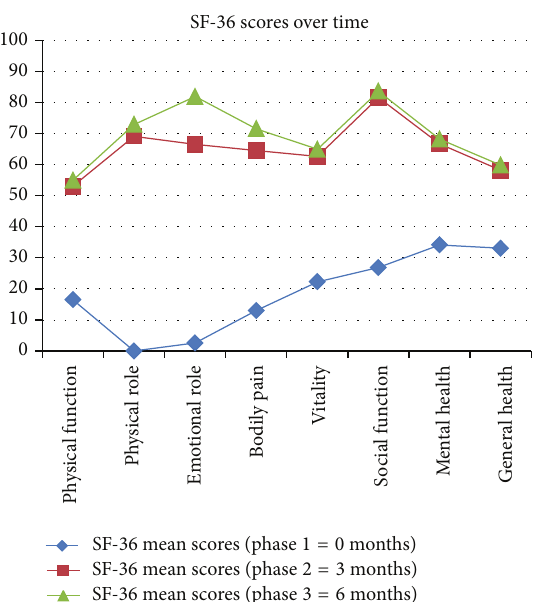
Figure 3: Illustration of the scores for every domain within the SF- 36 at baseline, at 3 months, and 6 months following TNF- 𝛼 inhibitor